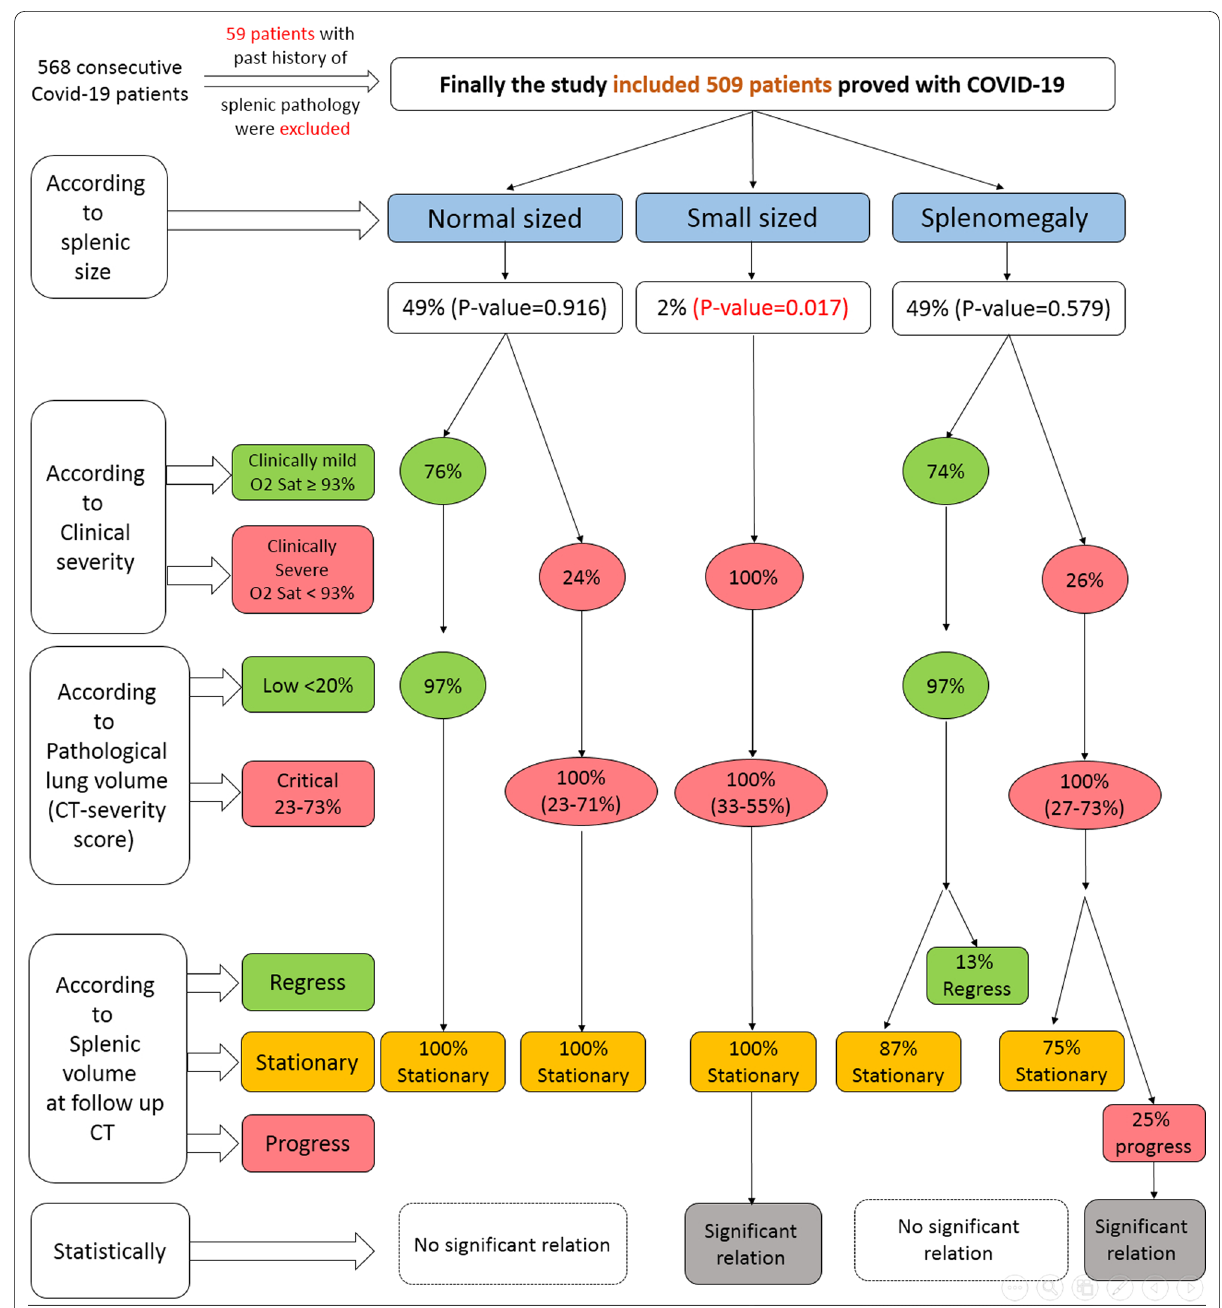
Fig. 9 A chart summarizing the results of the study regarding splenic size, clinical severity, pathological lung volume, follow-up, and statistical